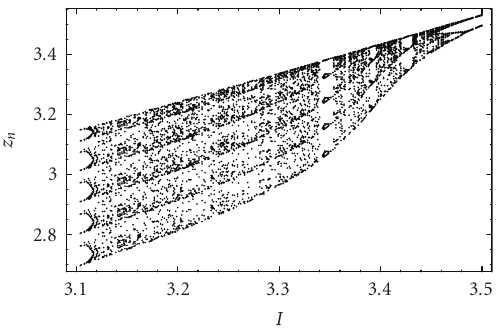
Figure 2.20. Bifurcation diagram for z n as a function of I , with r = 0 . 005 and s = 4 . 0.